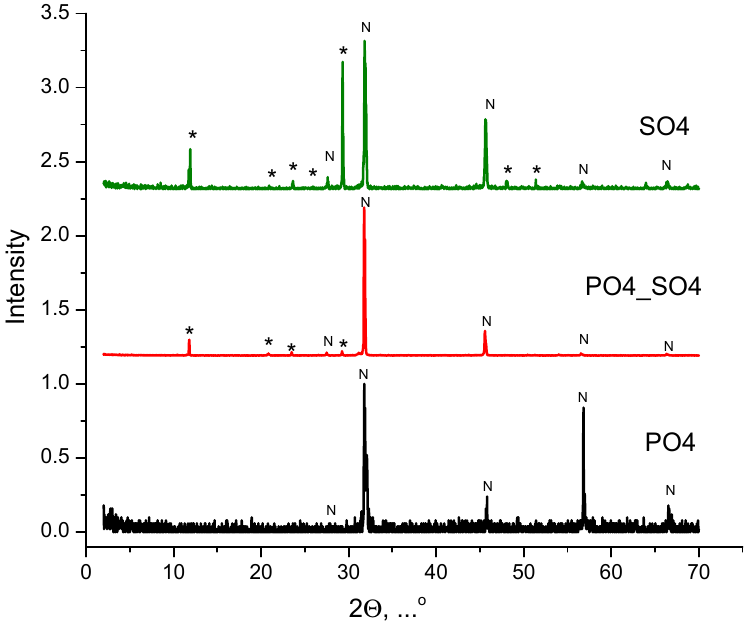
Figure 2. XRD data of products isolated from mother liquors formed during synthesis from aqueous solution of calcium chloride CaCl 2 and sodium sulfate Na 2 SO 4 (green line); from aqueous solution of calcium chloride CaCl 2 and sodium hydrophosphate Na 2 HPO 4 (black line); as well as from aqueous solution of calcium chloride CaCl 2 and mixed-anionic solution Na 2 HPO 4 /Na 2 SO 4 (red line): *—CaSO 4 · 2H 2 O (card PDF 21-816); N—NaCl (card PDF 5-628). Table 2. The composition of the products isolated from the mother liquors after separation of the precipitate, wt. %